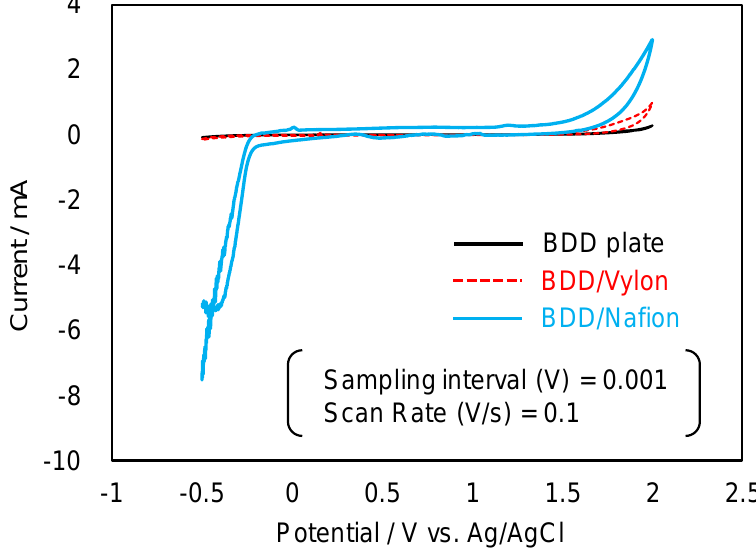
Figure 2. Cyclic voltammograms (vs. Ag/AgCl) of boron-doped diamond (BDD) electrodes in 0.5 M H 2 SO 4 .